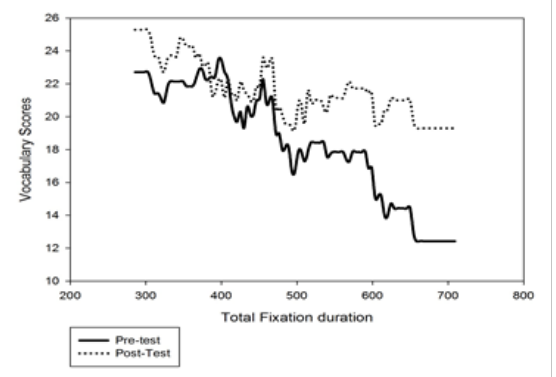
Figure 2. Noticing Threshold